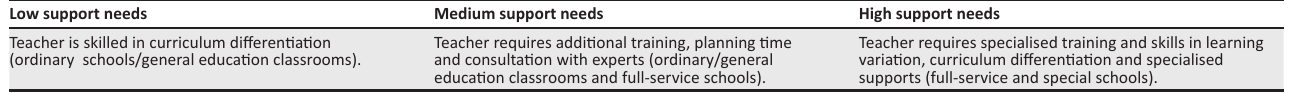
TABLE 1: Teachers’ required knowledge of curriculum differentiation at different levels of support needs. Low support needs Medium support needs High support needs Teacher is skilled in curriculum differentiation (ordinary schools/general education